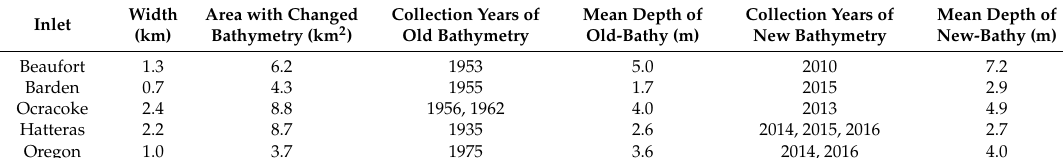
Table 1. Bathymetric data and morphological parameters around five North Carolina inlets.